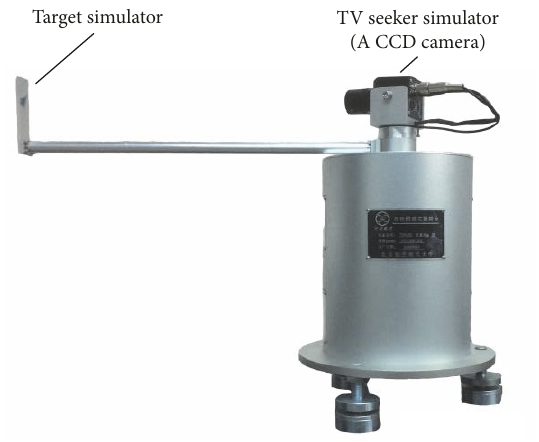
Figure 4: Dynamic turntable. Figure 5: Components connection diagram.